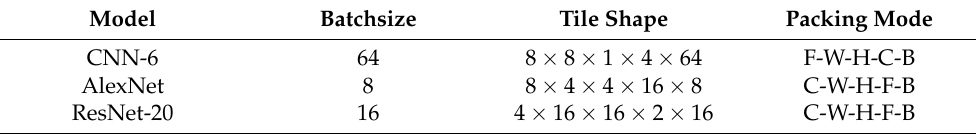
Table 3. Parameter setting of inference optimization